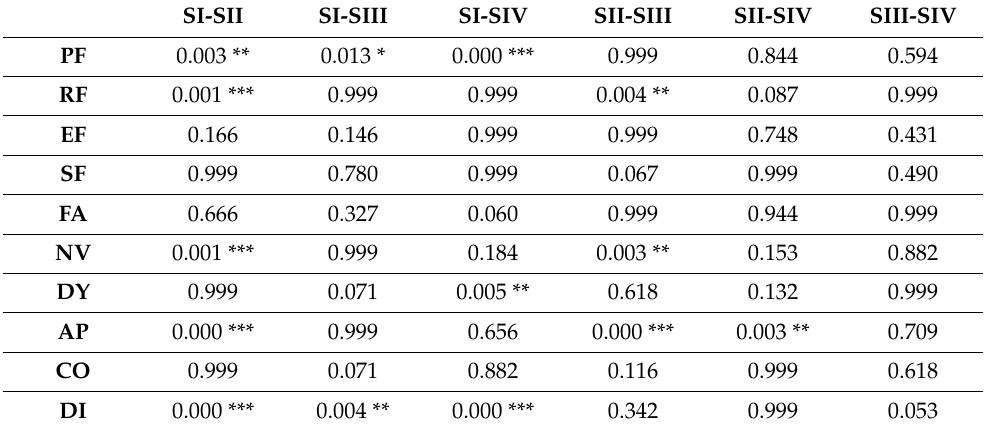
Table 8. Comparison of QOL (Quality of Life) scores between stages based on estimated marginal mean values with the application of Bonferroni correction for multiple comparisons (levels of significance from Table 7).